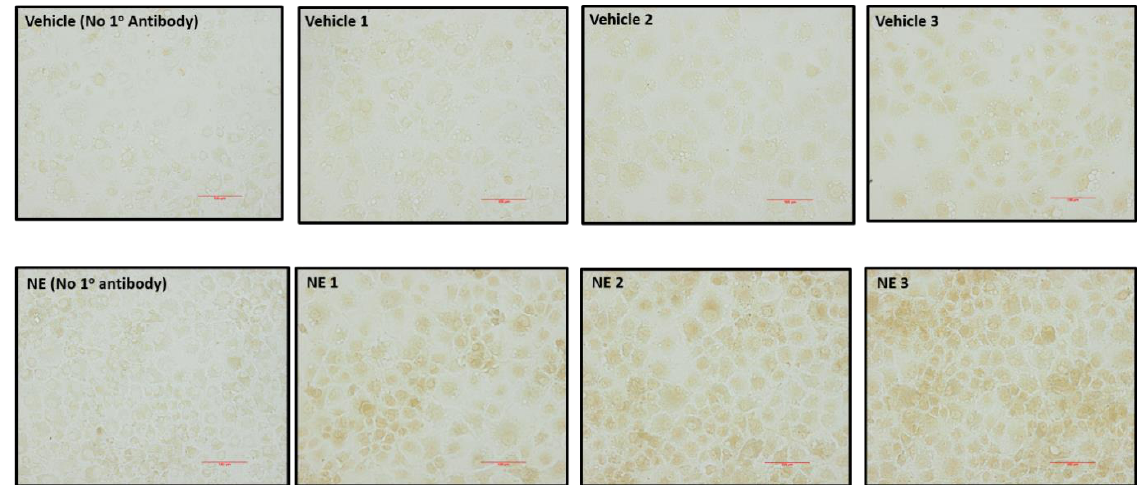
Figure 5. Immunocytochemical detection of NE induced SGLT1 expression in HK2 cells. Each image indicates an individual well of HK2 cells. SGLT1 staining is brown in colour. Size bar = 100 μ m.